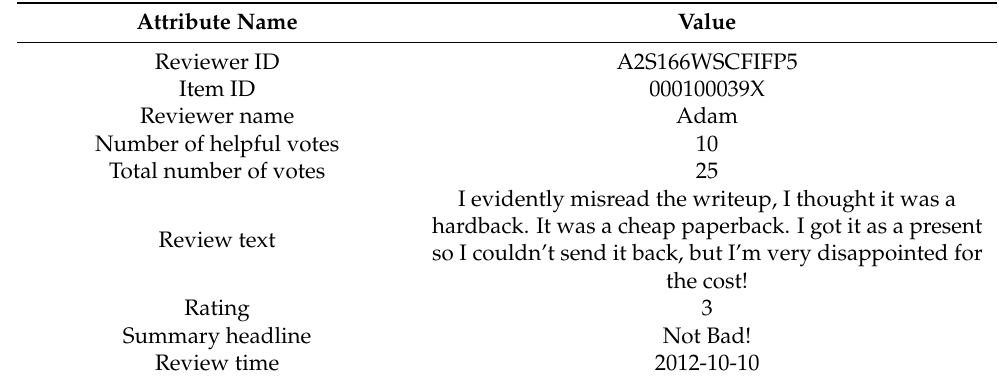
Table 2. An example Amazon Book dataset review composition.